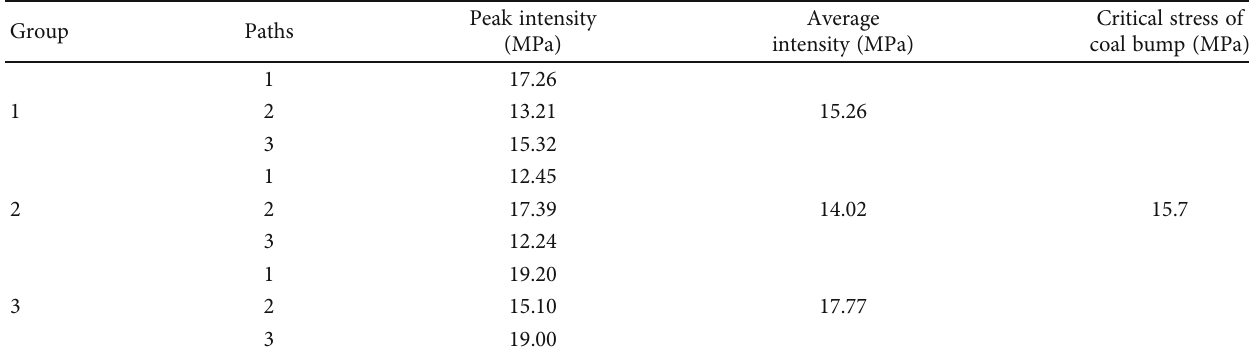
Table 2: Summary of peak intensity of 3 sets of coal samples.